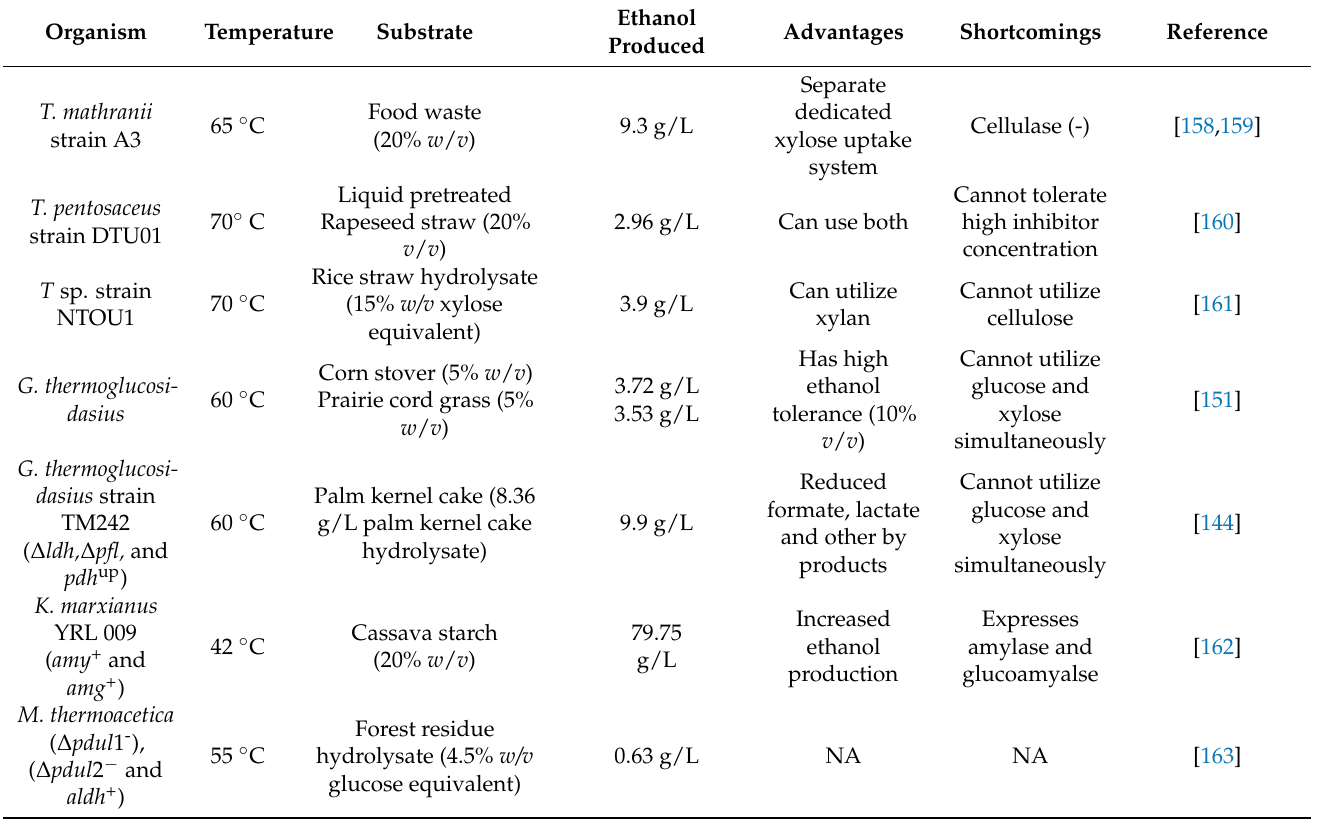
Table 3. Ethanol production by thermophiles using